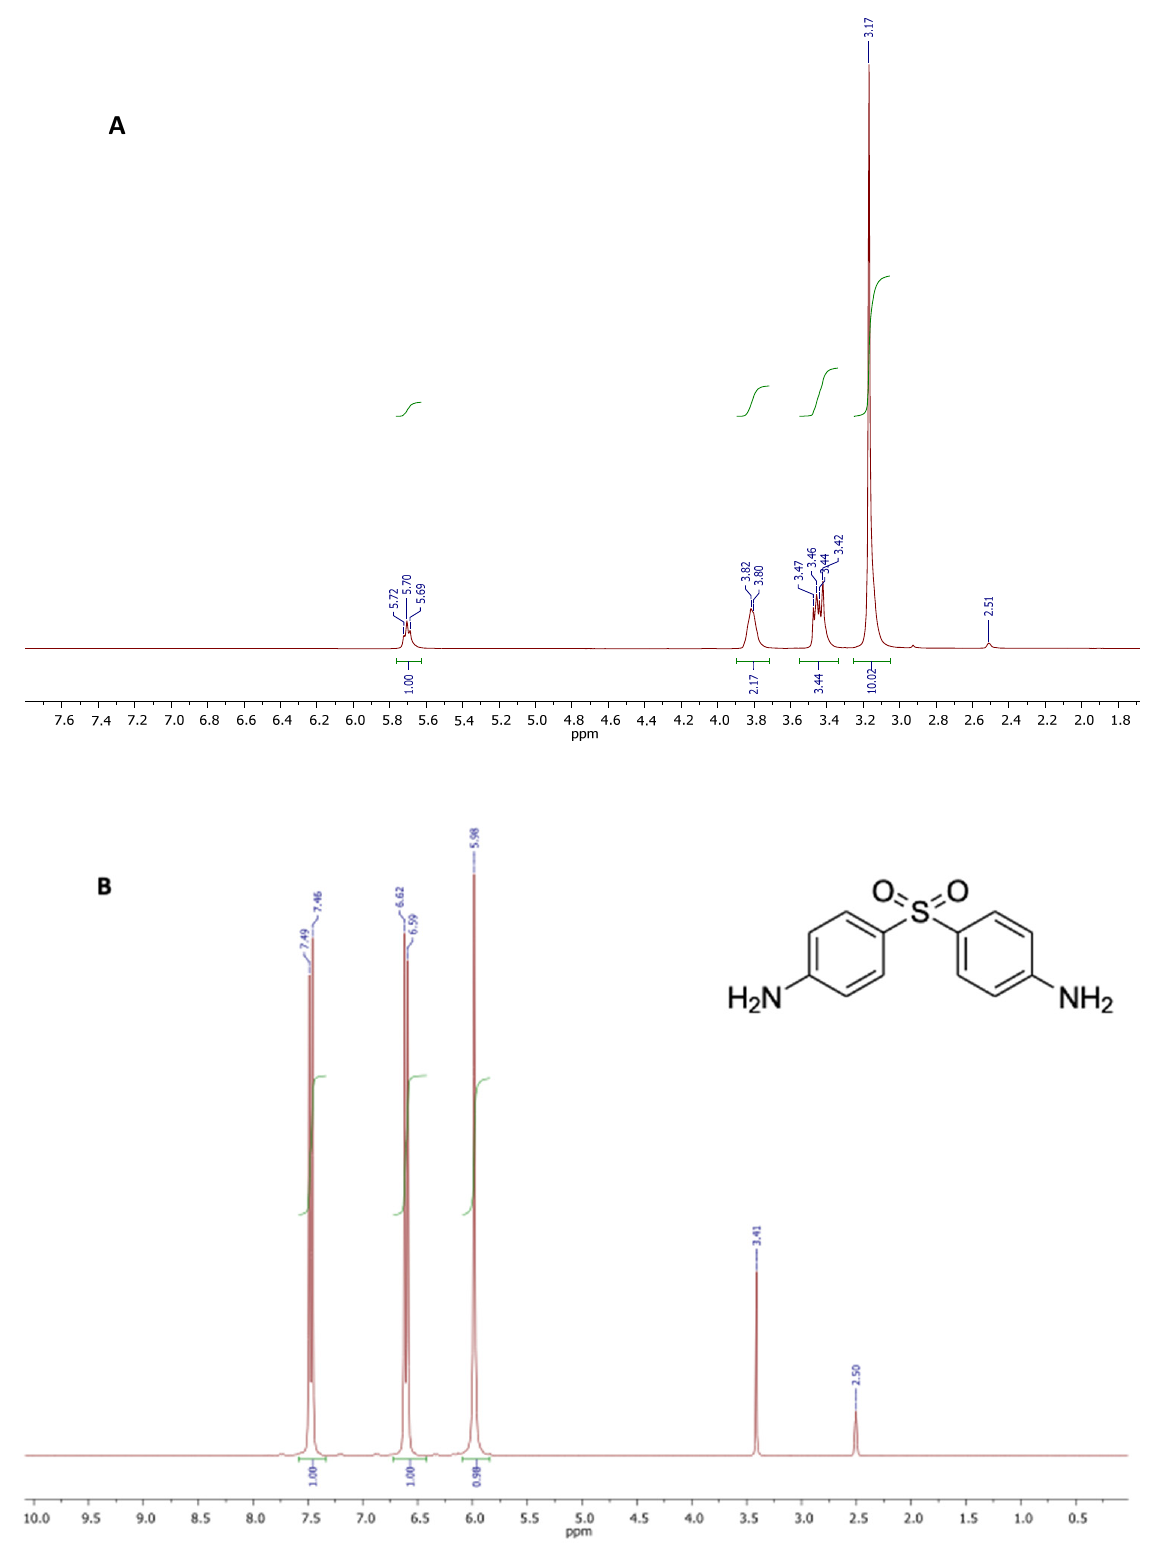
Figure 3. 1 H NMR spectra of choline chloride (CC) ( A ), and 4,4 ′ -diamino-diphenyl sulphone (dap- sone, DAP) ( B ).